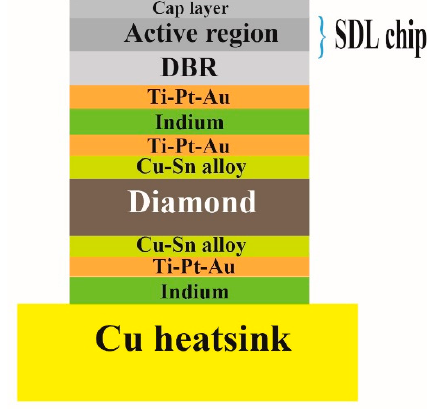
Figure 2. Schematic diagram of the bonding structure.